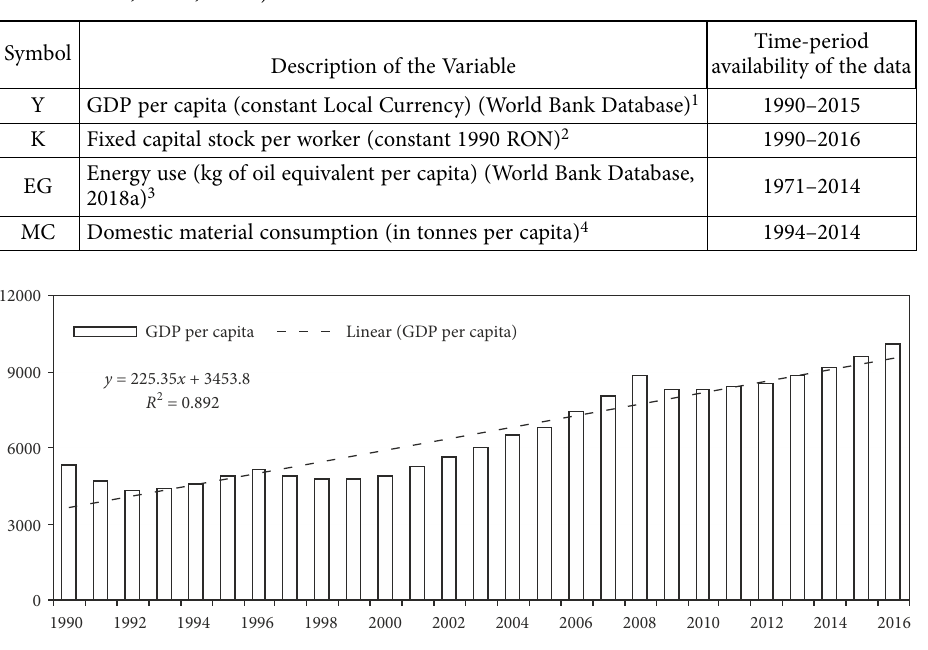
Figure 1. GDP per capita (constant 2010 US$) (source: authors based on World Bank Database, 2018a)